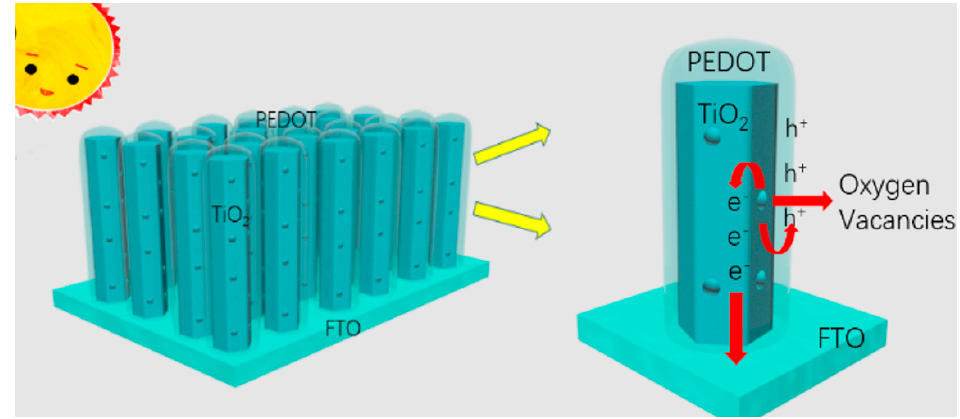
Figure 7. Schematic diagram of the mechanism of H-TiO 2 -PEDOT nanorod thin film under simulated